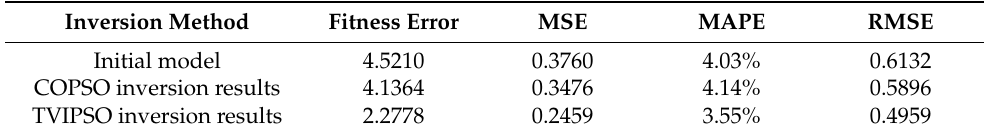
Table 4. Comparison of the iteration details for the two inversion